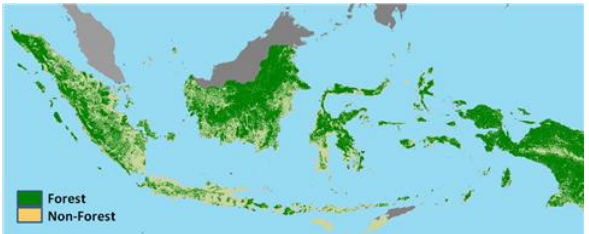
Figure 5. Illustration of forest extent (2012) at national scale.